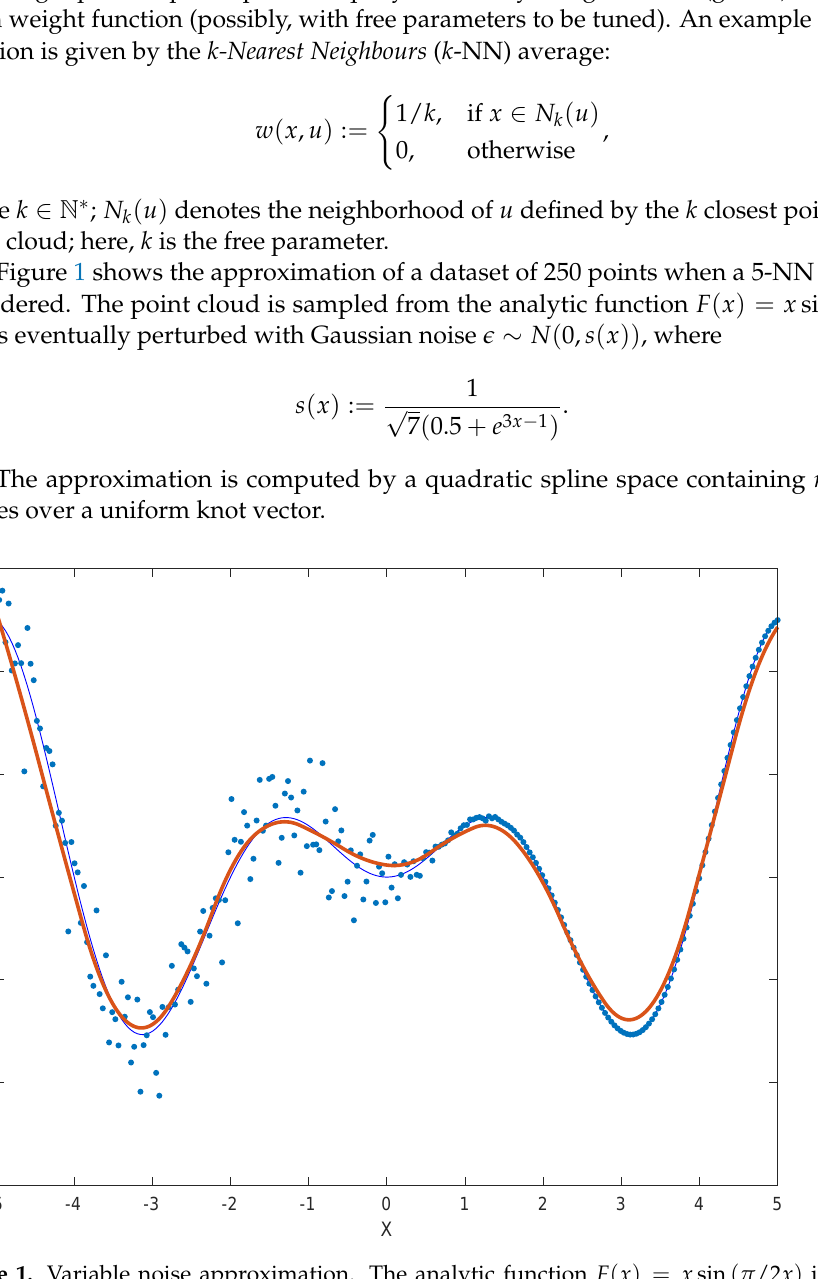
Figure 1. Variable noise approximation. The analytic function F ( x ) = x sin ( π /2 x ) is sampled and then perturbed with (non-uniform) Gaussian noise of mean 0 and the standard deviation of Equation (5). The resulting wQISA approximation, obtained by a 5-NN weight function, is displayed